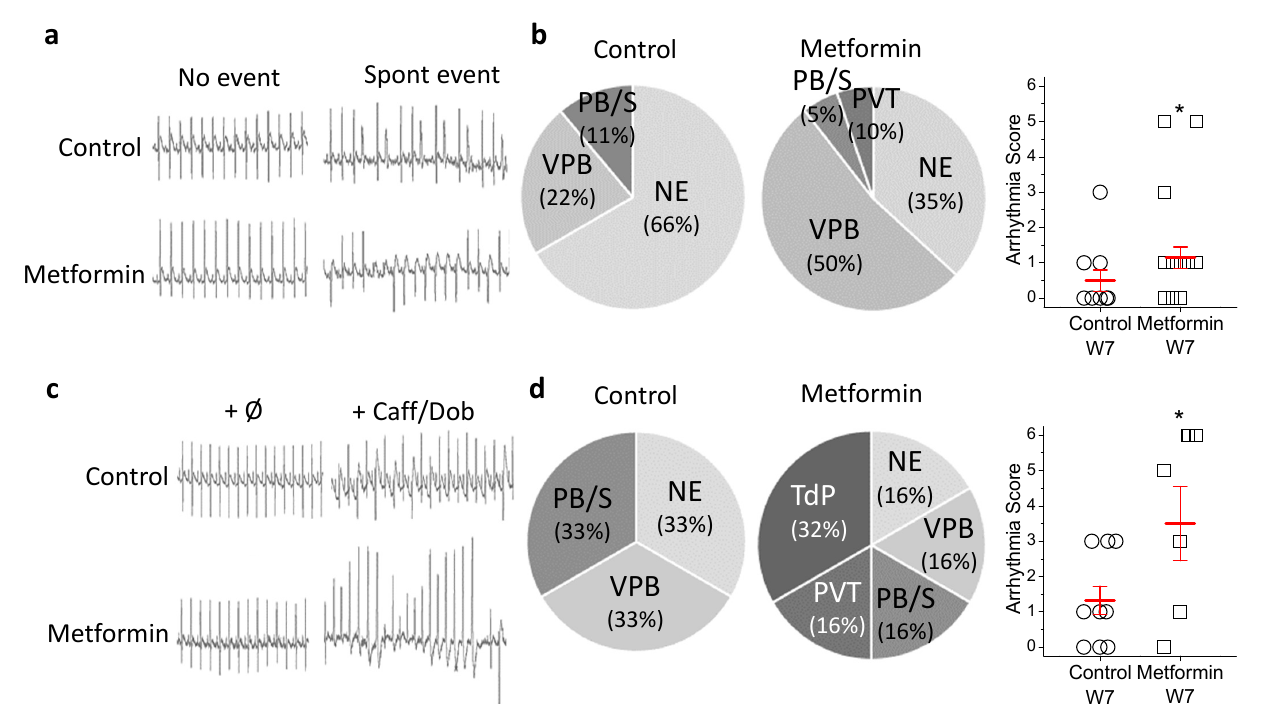
Figure 2. Metformin treatment increases the risk of severe arrhythmia under conditions of cardiac challenge. ( a ) ECGs of conscious animals during weekly monitoring. (Left), representative recordings from a control and a metformin-treated animal (35 mg/kg × day) that did not develop arrhythmic events. (Right), ECGs of the animals that showed the severest spontaneous event: persistent bigeminy in the control and non-sustained polymorphic ventricular tachycardia in the metformin-treated animal. ( b ) Pie charts and scatter plots showing the proportion and severity of each spontaneous event. From mildest to most severe: NE, no events; VPB, ventricular premature beat; PB/S, persistent bigeminy/salvos; PVT, polymorphic ventricular tachycardia; TdP, torsades de pointes. n = 9 control and 19 metformin-treated animals. ( c ) Representative ECGs of a control and a metformin-treated animal before (left) and after (right) the in vitro arrhythmia susceptibility assay performed at the end of the experimental period. Caffeine/dobutamine challenge triggers persistent bigeminy in the control, but torsades de pointes in the metformin-treated animal. ( d ) Pie charts and scatter plots showing the proportion and severity the proportion of each event after cardiac challenge. Data represent individual data points with mean ± SEM (red marks). * p < 0.05 compared to control. n = 9 control and 6 metformin-treated